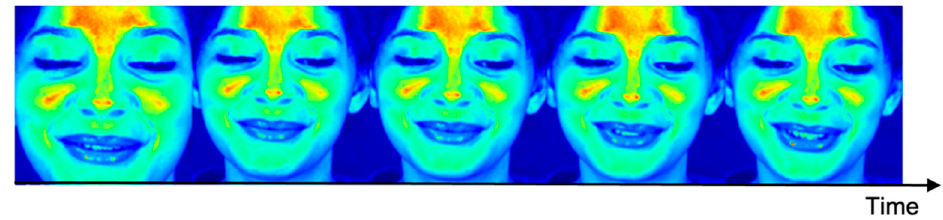
Figure 6. APNET LRP results.